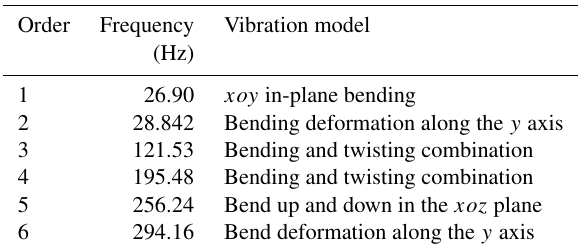
Table 7. Optimal nested-external-removal-type first six-order modes of the small